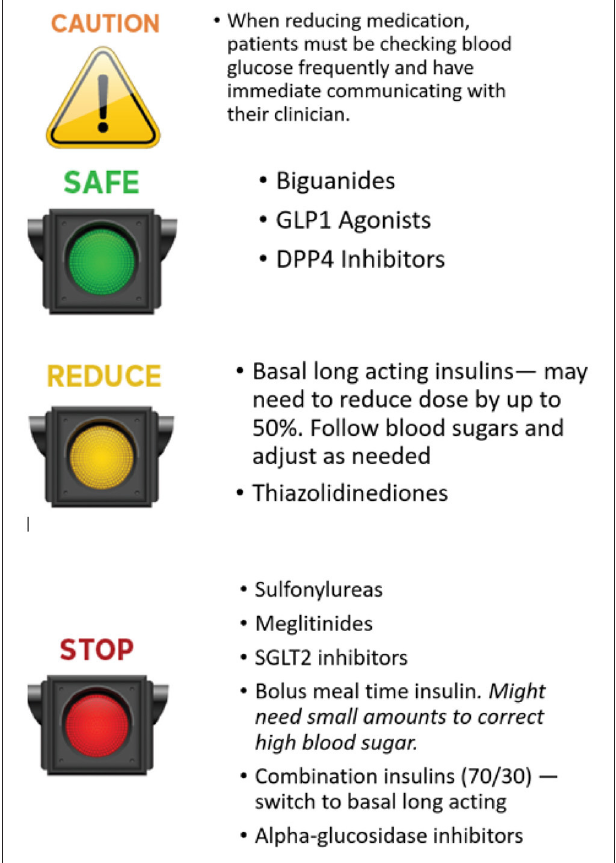
FIGURE 1 | Stoplight approach to medication management with therapeutic carbohydrate reduction.